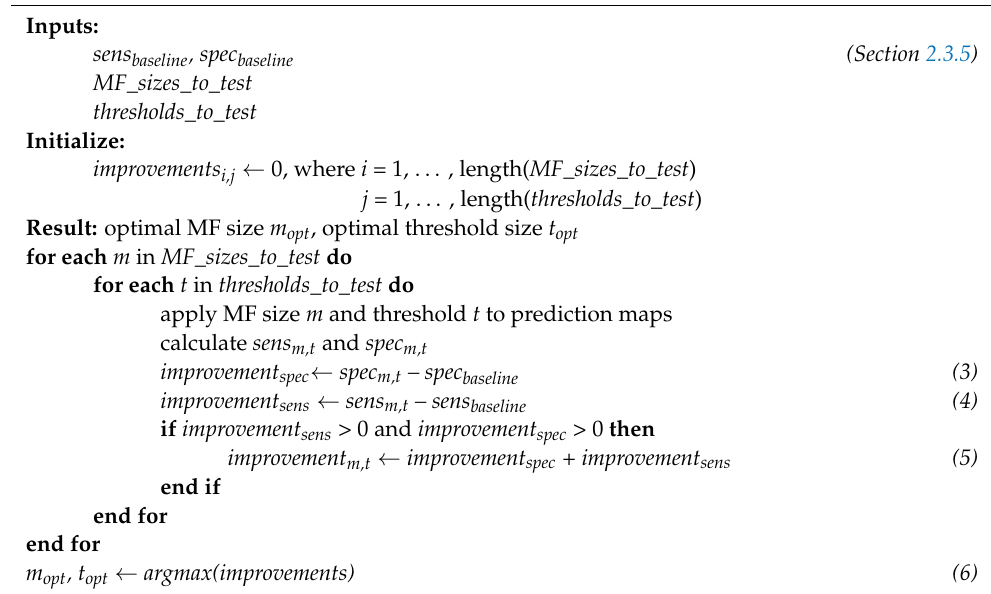
Algorithm 1. Finding optimal parameters of post-processing.